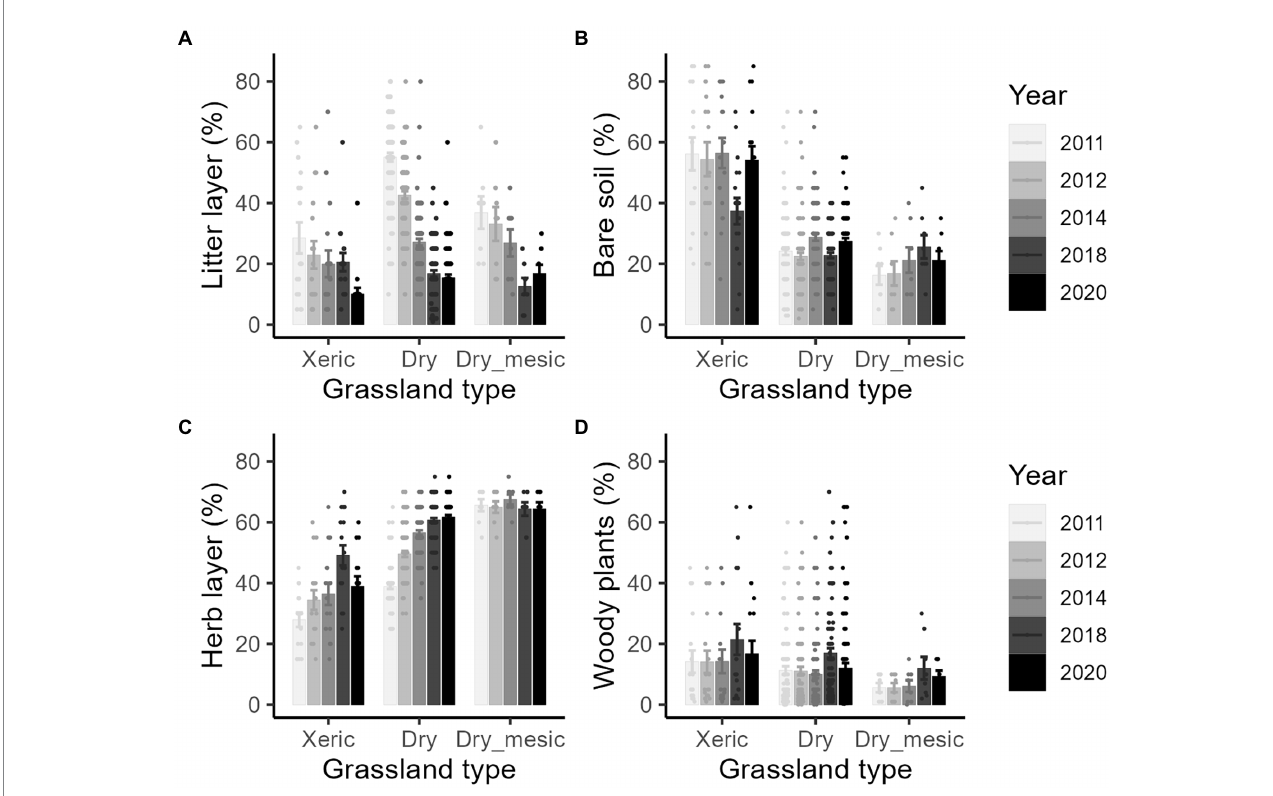
FIGURE 4 Mean values (± SE) of percent cover of habitat structures litter layer (A) , bare soil (B) , herb layer (C) and woody plants (D) on the grid cells (50 m × 50 m) in the year-round horse pasture in the different calcareous grassland types ( n = 121; xeric n = 17, dry n = 96, dry-mesic n = 8) in the years 2011, 2012, 2014, 2018 and 2020. Points correspond to the respective data